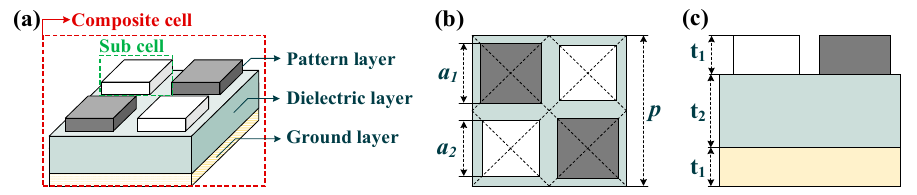
Figure 3. The ( a ) 3D view, ( b ) top view and ( c ) side view of a composite cell. The metal ground layer and pattern layer have the same thickness of t 1 ; the dielectric layer thickness is t 2 . The period of composite cell is p ; black and white sub cells have different side lengths, which are a 1 , a 2 , respec- tively.